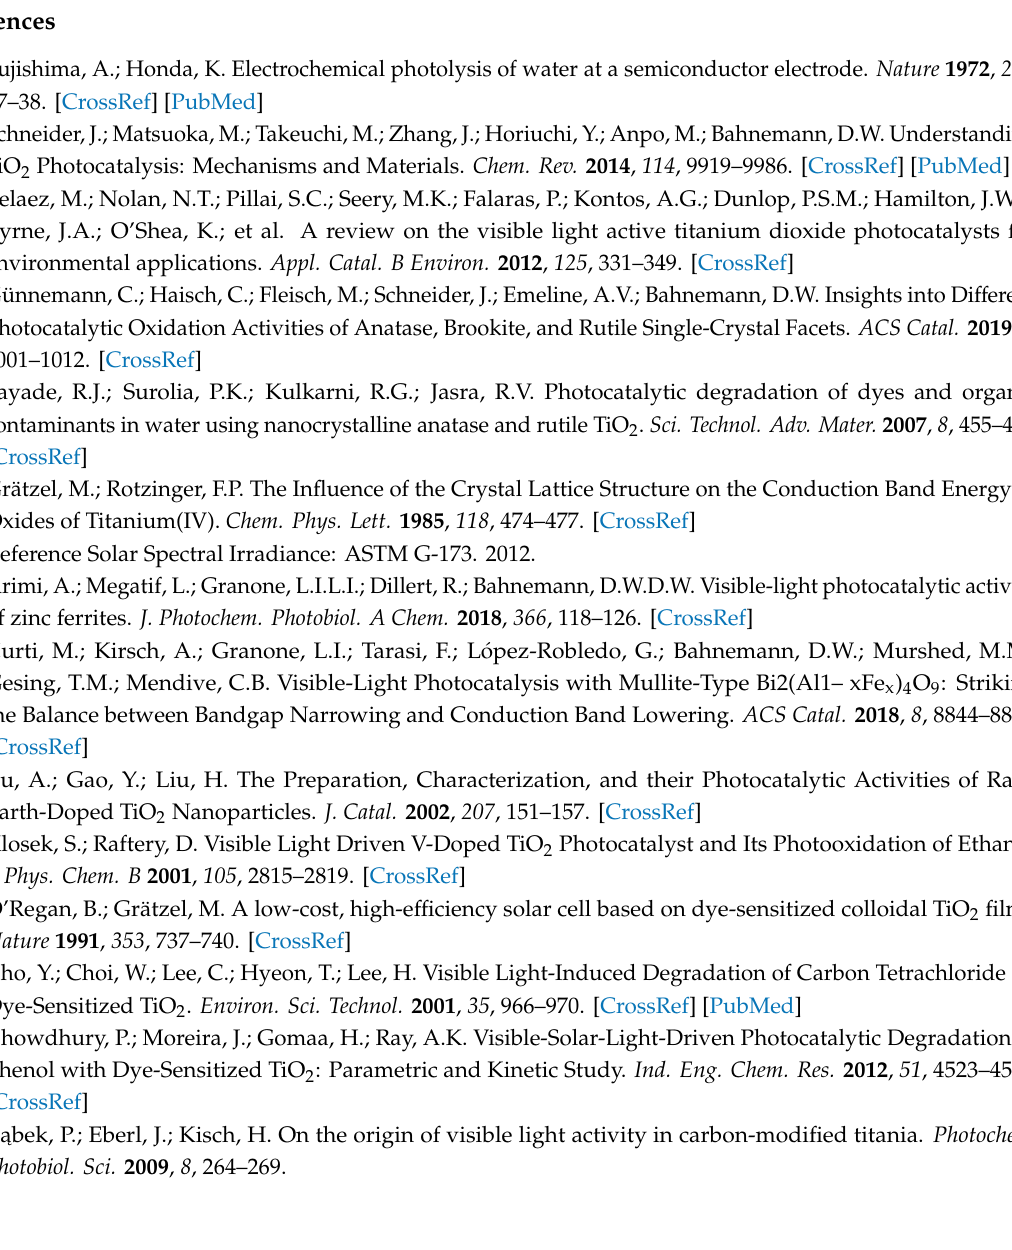
K-7000 under visible light irradiation, Figure S6: Photocatalytic conversion of chlorpromazine under visible light irradiation in the presence of K-7000 and Hombikat UV100, Figure S7: ( a ) Transient absorption decays of K-7000 observed at 550 nm and ( b ) transient absorption spectra of K-7000 measured at 100 ns after the laser excitation in an Ar atmosphere and in the presence of chlorpromazine after excitation with 455